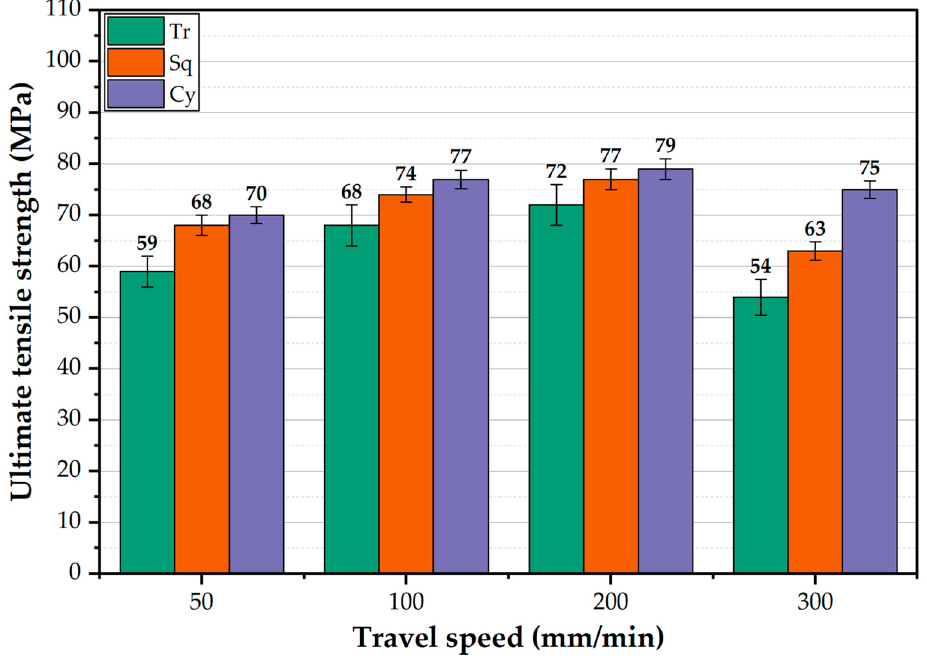
Figure 19. The UTS of the BT-FSPed AA1050 uses different pin geometries (Tr, Sq, and Cy) at travel speeds of 50, 100, 200, and 300 mm/min with applying a constant rotation speed of 600 rpm.